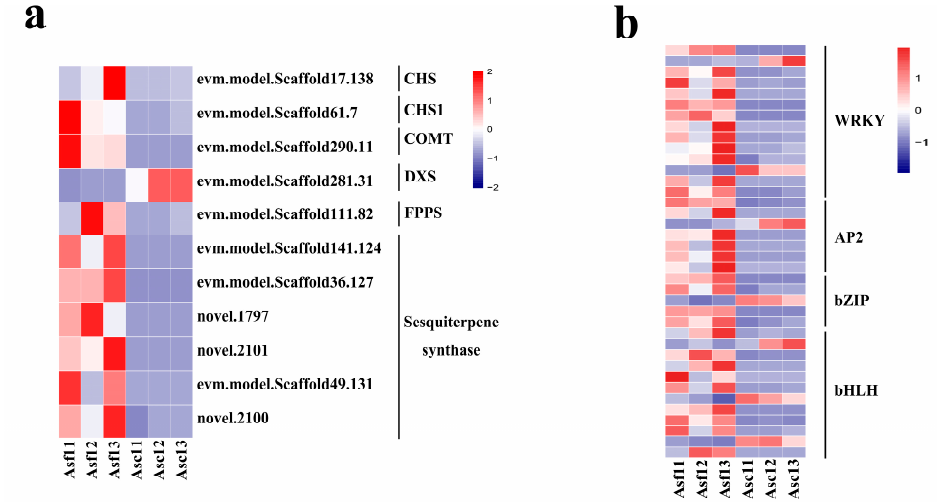
Figure 4. Expression profiling of DEGs and transcription factors. ( a ) Heatmap shows the expression patterns of the DEGs involved in the biosynthesis of 2-(2-phenylethyl)chromones and sesquiterpenes; ( b ) heatmap shows the expression patterns of the DEGs annotated as WRKY, AP2, bZIP, and bHLH TFs. Each row represents each DEG, and each column represents the expression level from different samples. The color from blue to red represents gene expression from low to high.